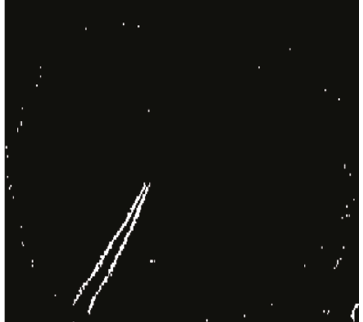
Figure 13: Image after boundary detection using our method with threshold of − 0.005.